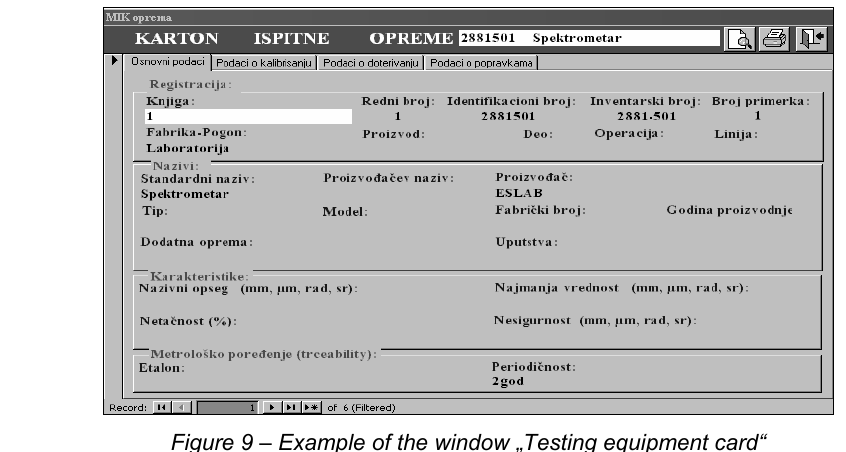
Figure 9 – Example of the window „Testing equipment card“ Рис . 9 – Пример окна " Журнал испытательного оборудования " Слика 9 – Пример прозора „ Картон испитне опреме